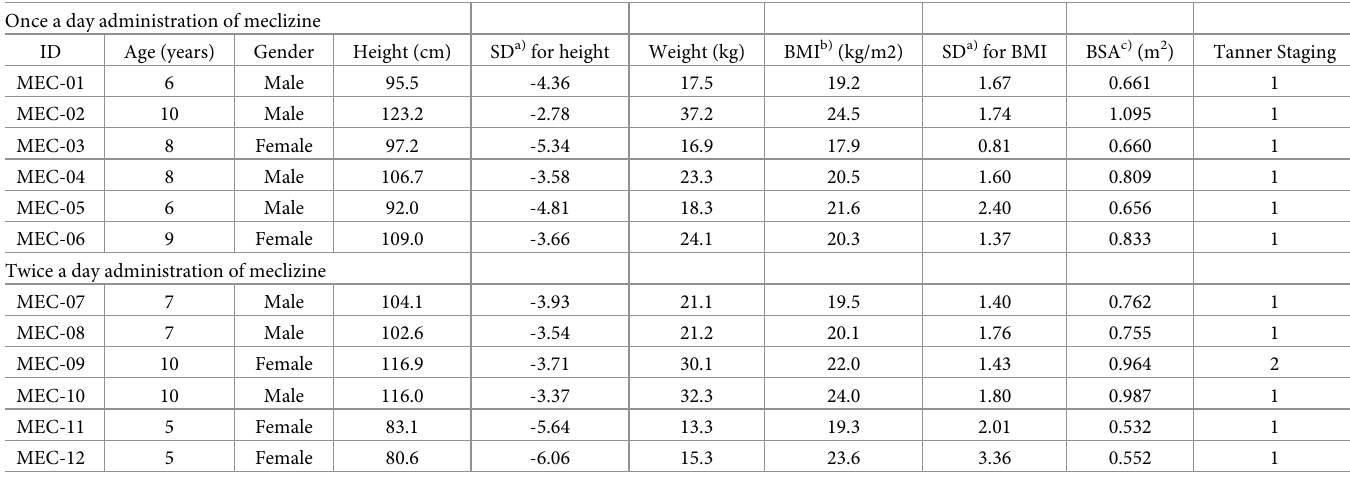
Table 1. Summary of subject baseline